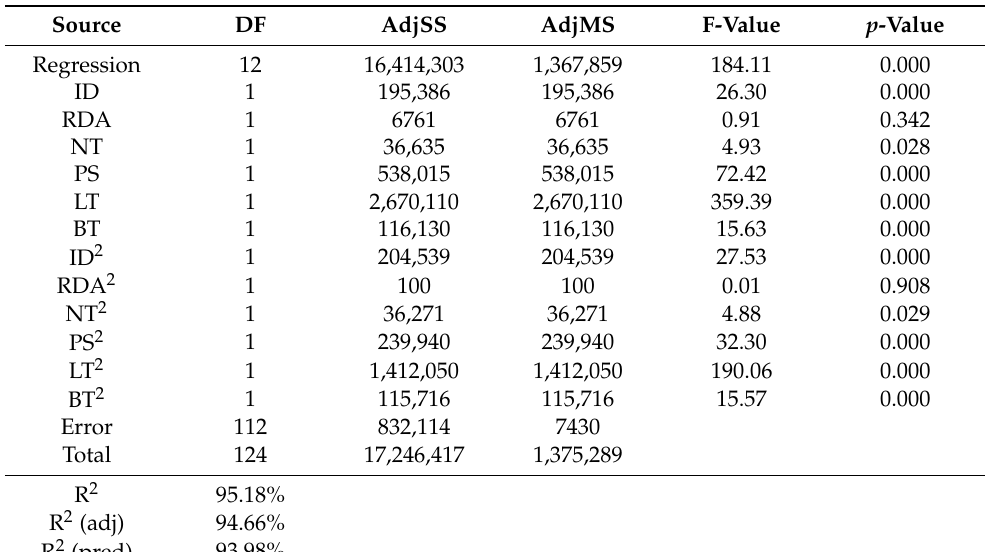
Table 4. Polynomial ANOVA, printing time vs. ID, RDA, NT, PS, LT, and BT. Source DF AdjSS AdjMS F-Value p -Value